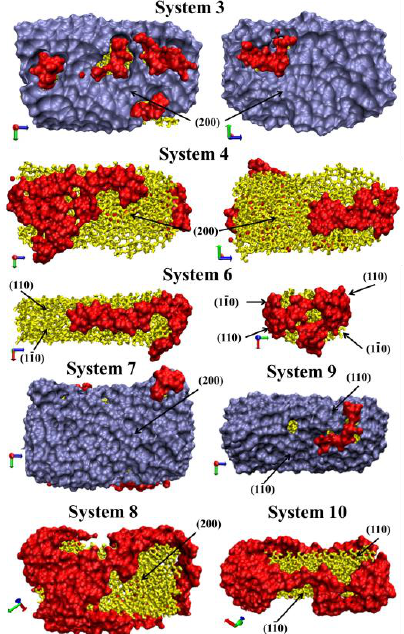
Figure 7. Snapshots of solvation shells at a distance of 0.5 nm from CNC (yellow) for System 3, System 4, System 6, System 7, System 9, System 8, System 10. The ice blue surface denotes the water shell and the red surface denotes the places of the PAM direct contact with CNC. For better understanding, the hydrophobic (200) and hydrophilic (110, 1–10) facets are marked.